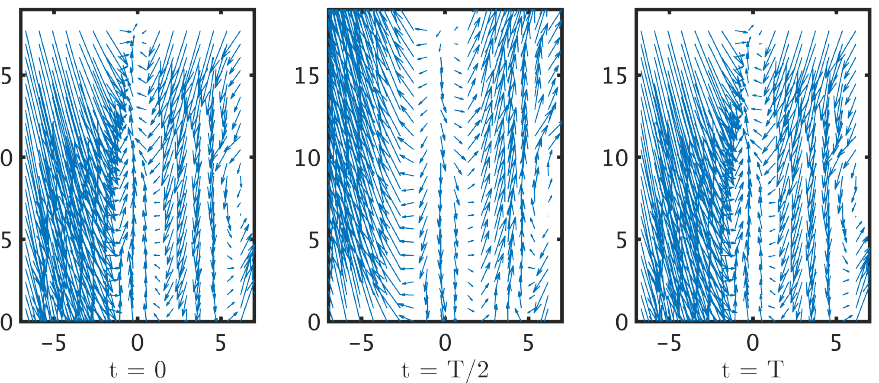
Figure 11. Flow patterns in the pair of robust modes 6 and 7 whose eigenvalues are − 0.013 ± 0.489 i and whose period is T = 1.28 ms.